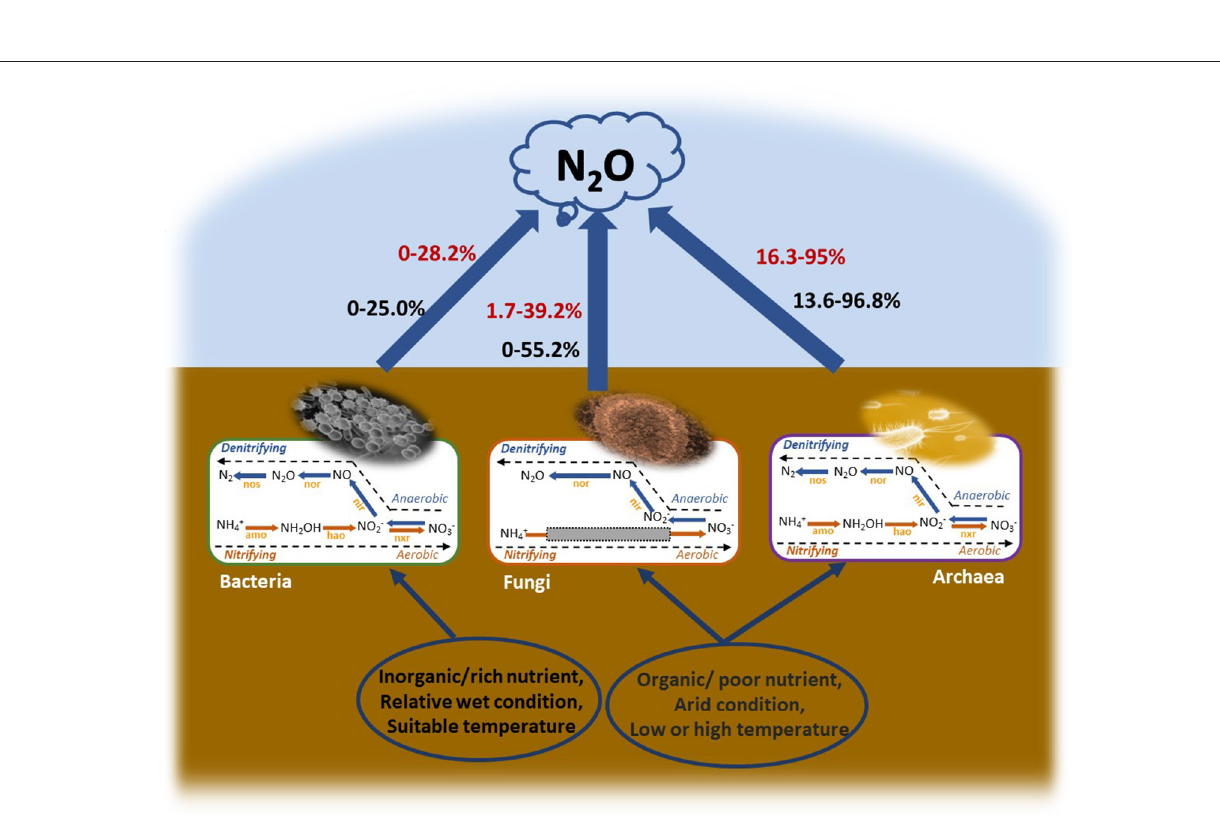
Frontiers in Microbiology | www.frontiersin.org